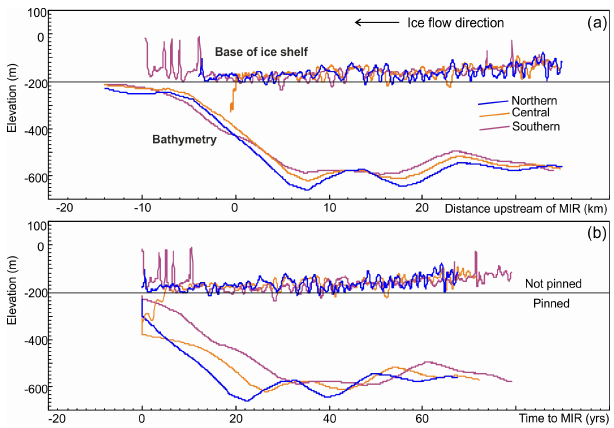
Figure 6. Cross section of the McDonald Bank and the Brunt Ice Shelf showing ice shelf draft and bathymetry along three flow lines upstream of the MIR (the position of these flow lines is marked in Fig. 4d). The flow lines are plotted as a function of both (a) dis- tance and (b) time from the McDonald Bank calculated from feature tracking between Sentinel-1 satellite images on 18 and 30 June 2015 (De Rydt et al., 2018). The horizontal line approximates the highest known point of the McDonald Bank. Where the ice shelf draft falls below the horizontal line we infer contact between the ice shelf and the bed; where it falls above the line the ice shelf will potentially become detached. This figure shows the significance of the iceberg keels in maintaining contact with the McDonald Bank. Note that the rapid increase in ice shelf draft in the “central” flow line approach- ing 0km is considered a data anomaly, which may have resulted from the complex surface topography at the McDonald Ice Rum-